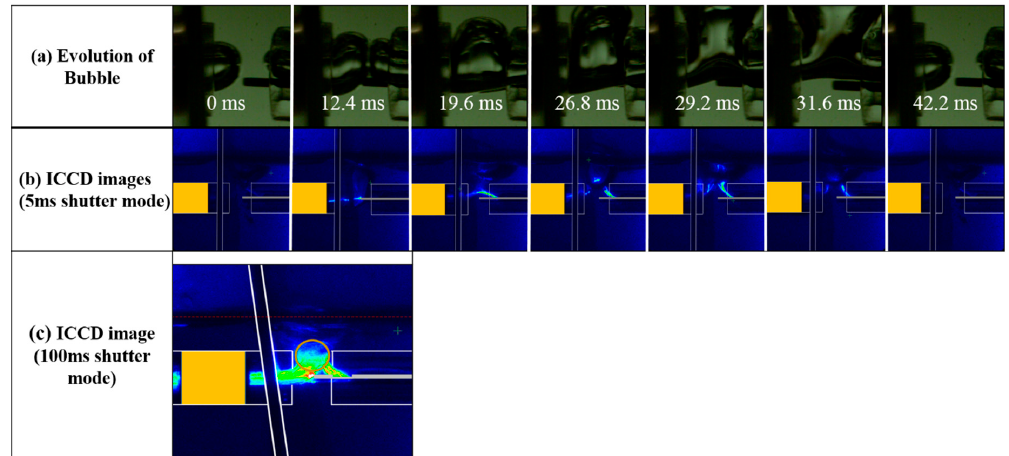
Figure 2. ( a ) Temporal evolution of the gas bubble in liquid aniline without discharge using a high-speed camera, ( b ) DBD images taken during exposure time of 5 ms in the shutter mode of an ICCD, and ( c ) a DBD image taken during exposure time of 100 ms in the shutter mode of an ICCD.